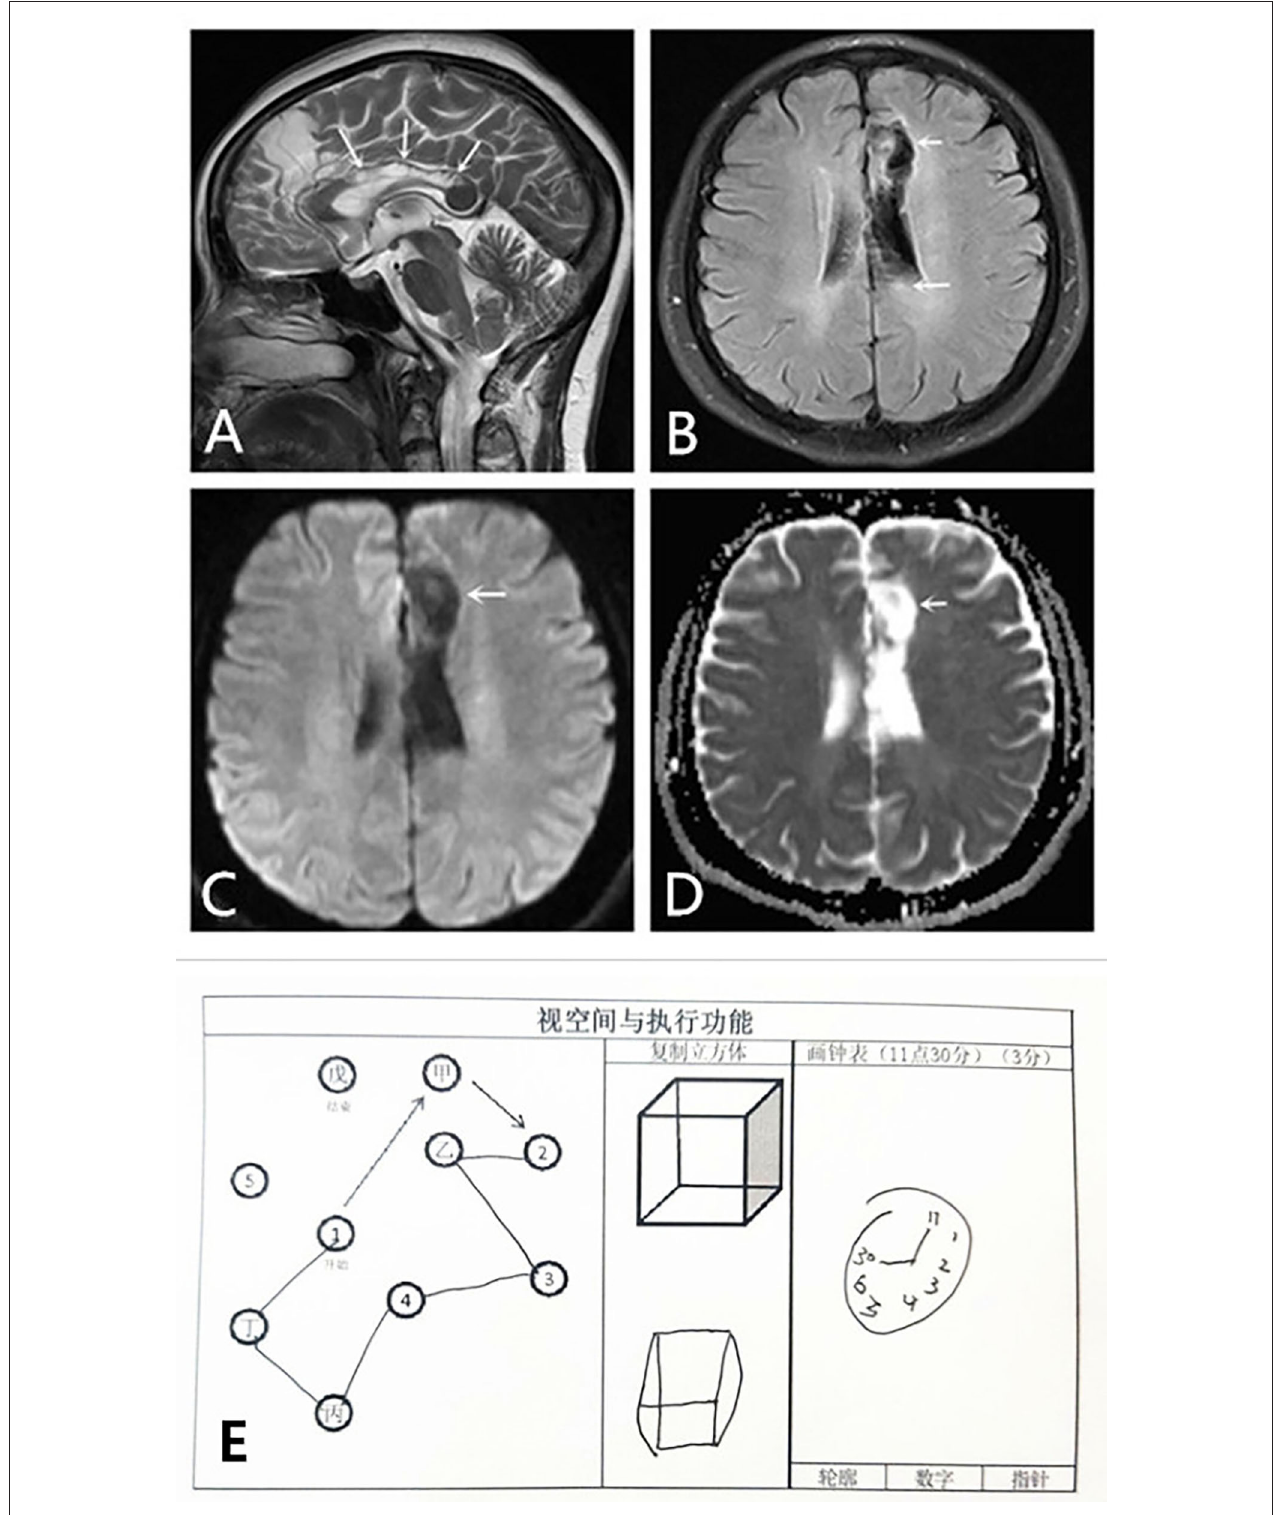
FIGURE 2 | Cytotoxic edema and visuospatial and executing skills of the dominant hand of the patient improved in 3 months. MRI: (A,B) Sagittal T2WI scan and axial T2 FLAIR show obvious improvement of cytotoxic edema in the left frontal lobe and the body of the corpus callosum. Encephalomalacia foci and gliocyte hyperplasia can be observed in these areas. (C,D) DWI and ADC scans show no limitation of diffusion. The patient failed to recognize spatial structure; however, she has made some progress after this period of recovery (E) . ADC, apparent diffusion coefficient; DWI, diffusion-weighted imaging; FLAIR, fluid-attenuated inversion recovery; MRI, magnetic resonance imaging; T2WI, T2-weighted